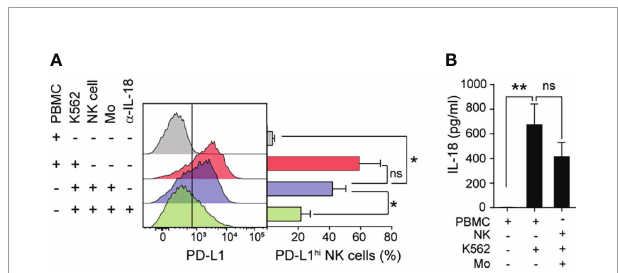
FIGURE 5 | Monocyte-derived IL-18 induces PD-L1 expression on tumor- experienced NK cells. (A) Frequency of PD-L1 hi NK cells after culture of PBMC in the absence or in the presence of K562, isolated NK cells in the presence of K562 cells and/or autologous monocytes (Mo), in the absence or in the presence of an anti-IL-18 neutralizing mAb for 48 h, assessed by fl ow cytometry. (B) concentration of IL-18 in supernatants of the cultures, assessed by ELISA. Data represent mean ± SEM, (n=4). One-way ANOVA with Dunnett´s post hoc test. ns, non-signi fi cant; * p <0.05, ** p